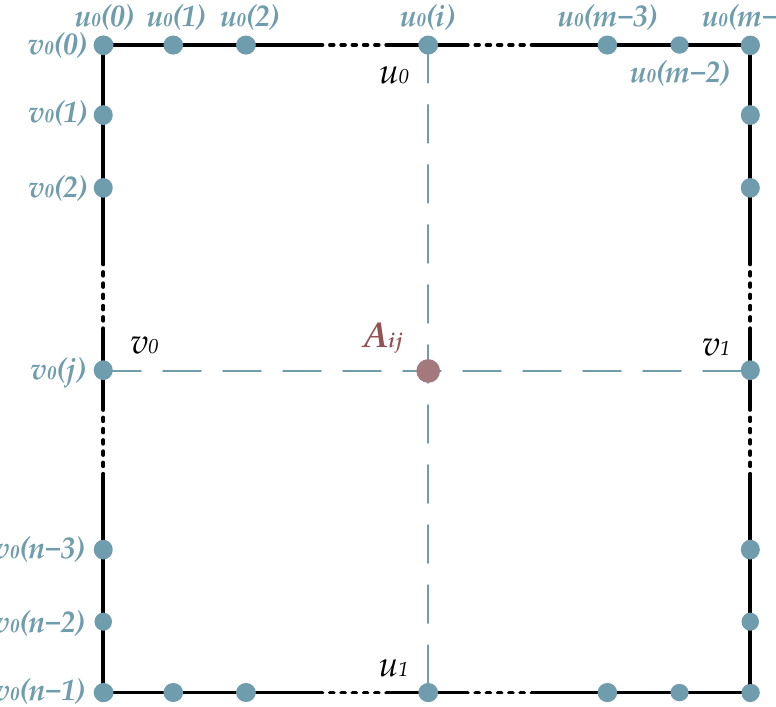
Figure 8. Schematic diagram of the side processing of the four-sided region: ( a ) the original four- sided region; ( b ) the formed sides and the points inserted on them; ( c ) the result of the polygon triangulation of the new and old sides.